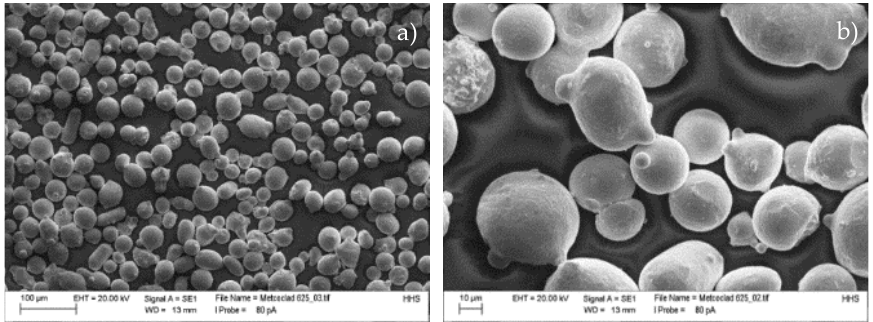
Figure 4. Scanning electron microscope (SEM) images of the powder with − 53 + 20 µ m grain fraction [1], ( a ) Overview; ( b ) Detail. Reprinted with permission from Ref [1]. Copyright 2020, Fraunhofer Verlag.